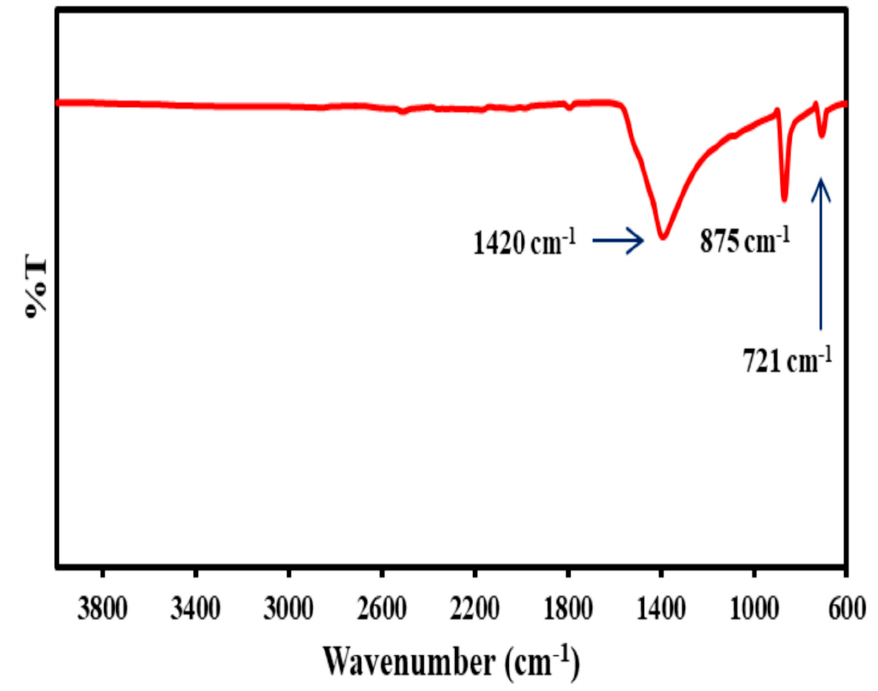
Figure 10. FTIR spectrum of CaO.